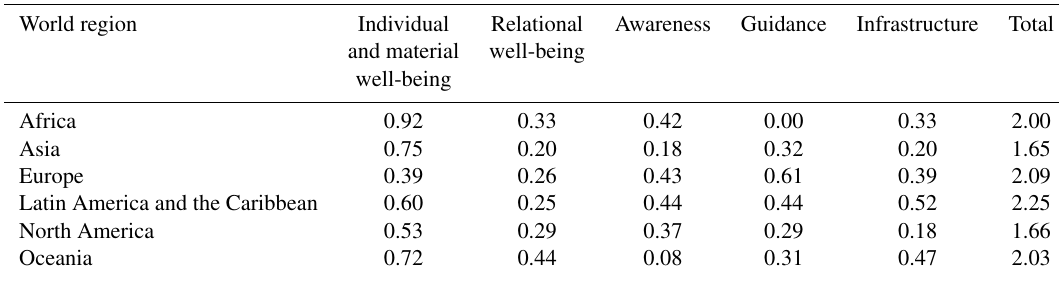
Table 3. Fraction of all communities in each region, which are reported to have used responses from any of the five response classes. Totals exceed 1.00 because communities use responses from more than one class. World region Individual Relational Awareness Guidance Infrastructure Total and material well-being well-being Africa 0.92 Asia Europe Latin America and the Caribbean